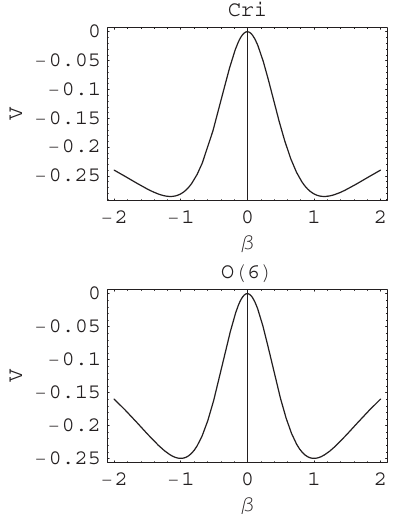
Figure 2. The potential function in β obtained from (6) at the critical point x = 0 . 5 and the potential in the O(6) limit corre- sponding to (1) with χ =